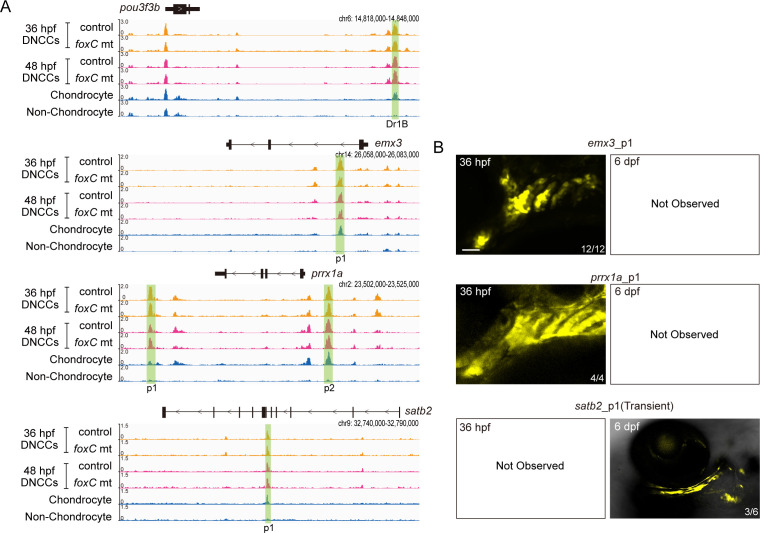
In vivo validation of accessible elements from Group I.(A) Genomic regions (gene loci and GRCz10 coordinates listed) for enhancer testing. Peaks (p) tested are shown in green, and μATACseq reads are shown in each row. DNCCs, dorsal CNCCs. (B) GFP expression (yellow) driven by the indicated peaks at 36 hpf and 6 dpf. For emx3_p1 and prrx1a_p1, confocal projections of whole arch CNCCs of stable transgenic zebrafish are shown in lateral view at 36 hpf. For satb2-p1, confocal section of representative injected embryo is shown in lateral view at 6 dpf, with DIC providing embryo context in white. Numbers indicate proportion of embryos positive for the co-selectable lens:CFP marker (also on the injected plasmid) in which the displayed patterns were observed. Scale bar = 100 μm.